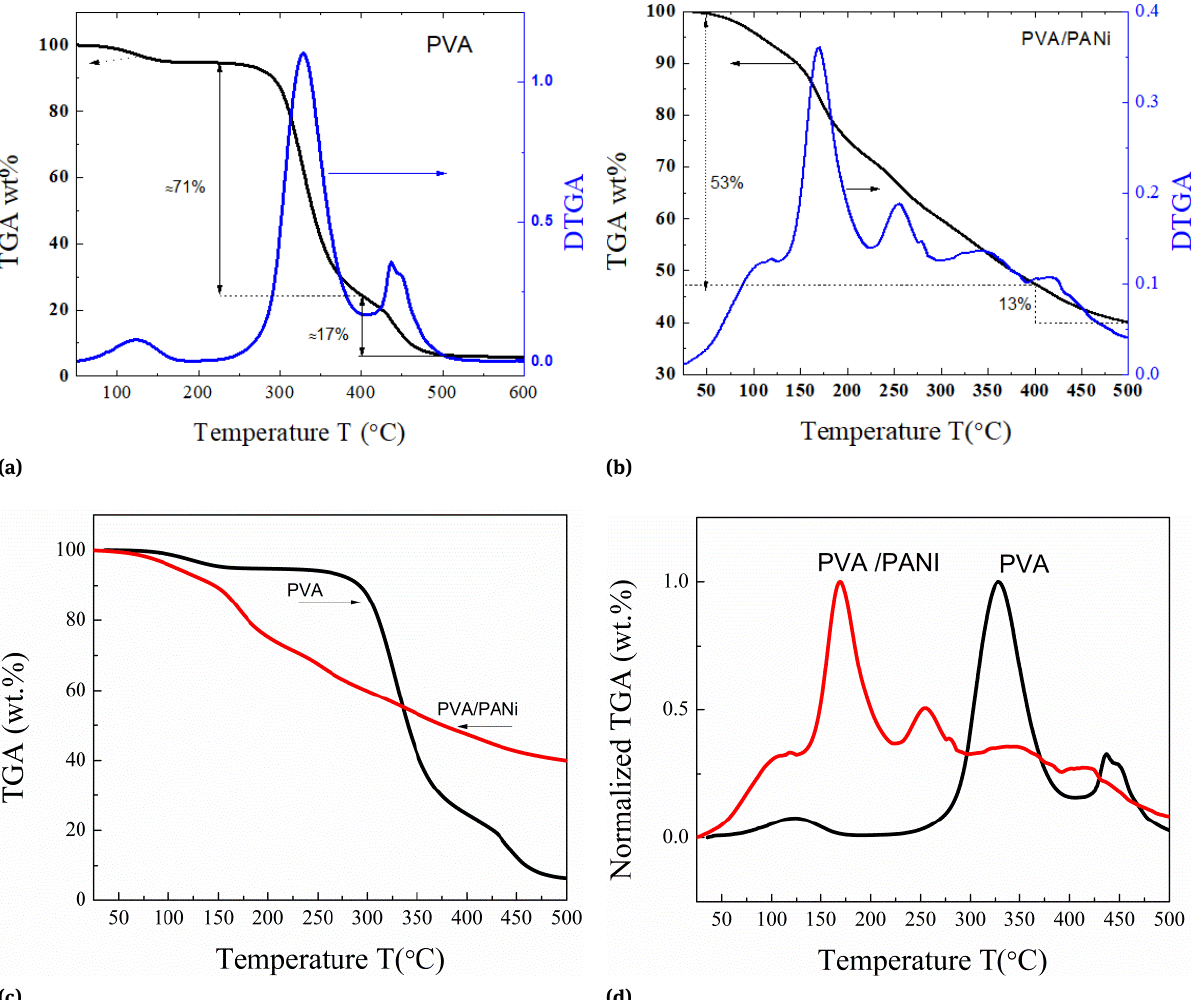
Figure 9: TGA and DTGA curves for a) pure PVA b) PVA/PANi blend, and a comparison of c) TGA and d) DTGA curves for pure PVA and polymer blend